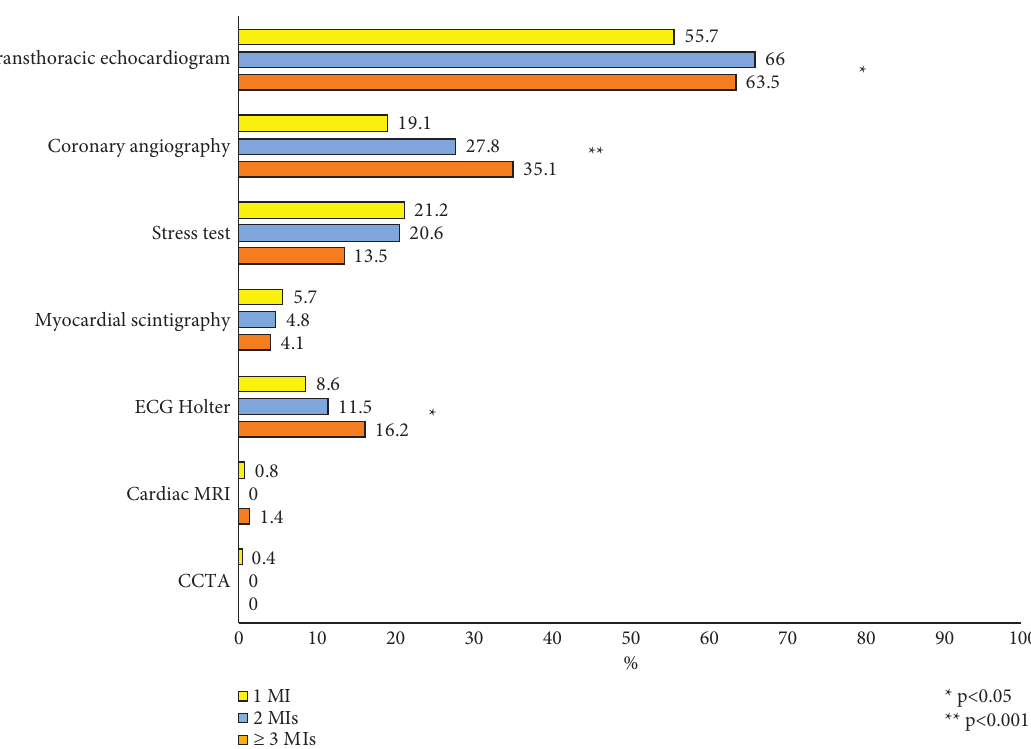
Figure 1: Diagnostic procedures performed within 12months before enrolment in the 3 groups. CCTA: coronary computed tomography angiography; MRI: magnetic resonance imaging.